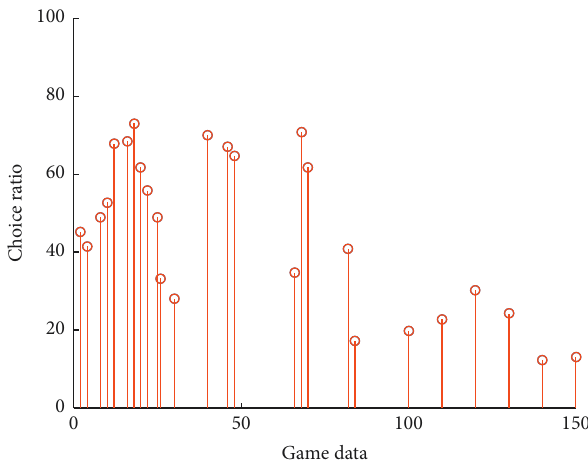
Figure 7: Analysis of the selection ratio of network knowledge